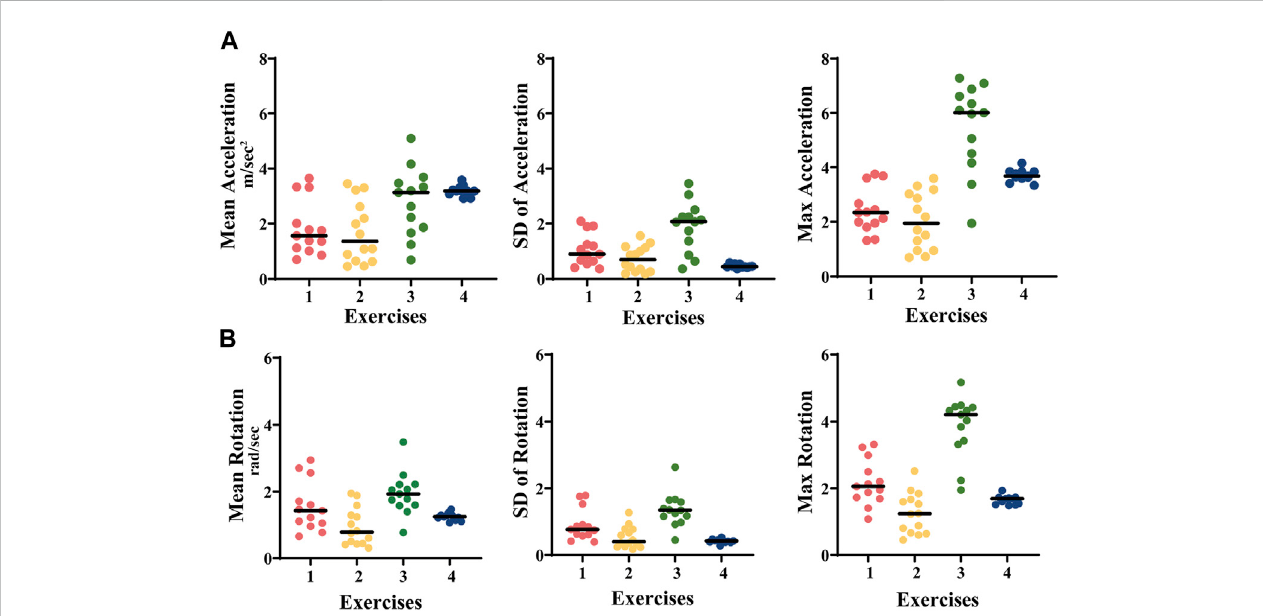
FIGURE 4 (A) Acceleration (m/sec 2 )and (B) rotation rate (grad/sec) during thefour exercises in14 healthycontrols.Exercise 1: cherry picking, exercise 2:little fl yer, exercise 3: shadow boxing, exercise 4: hand biking.